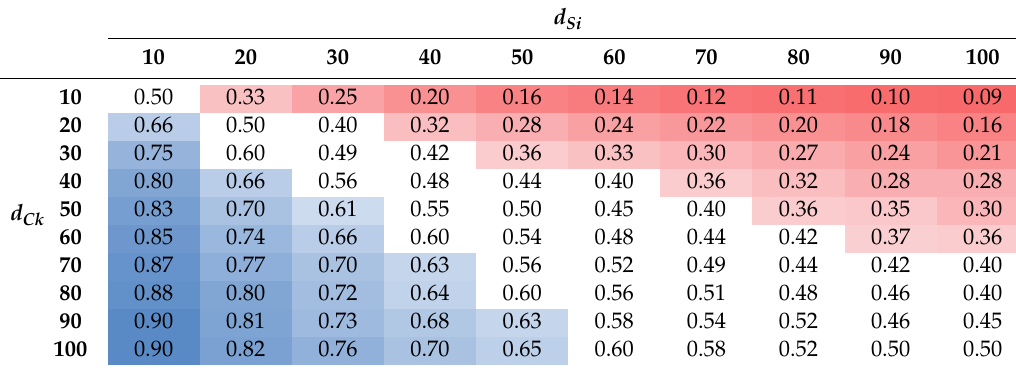
Table 4. Measured undetectability M U of our TDOA-U according to values of d Si and d Ck . M U is blue-colored when M U > 0.6 and M U is red-colored when M U <